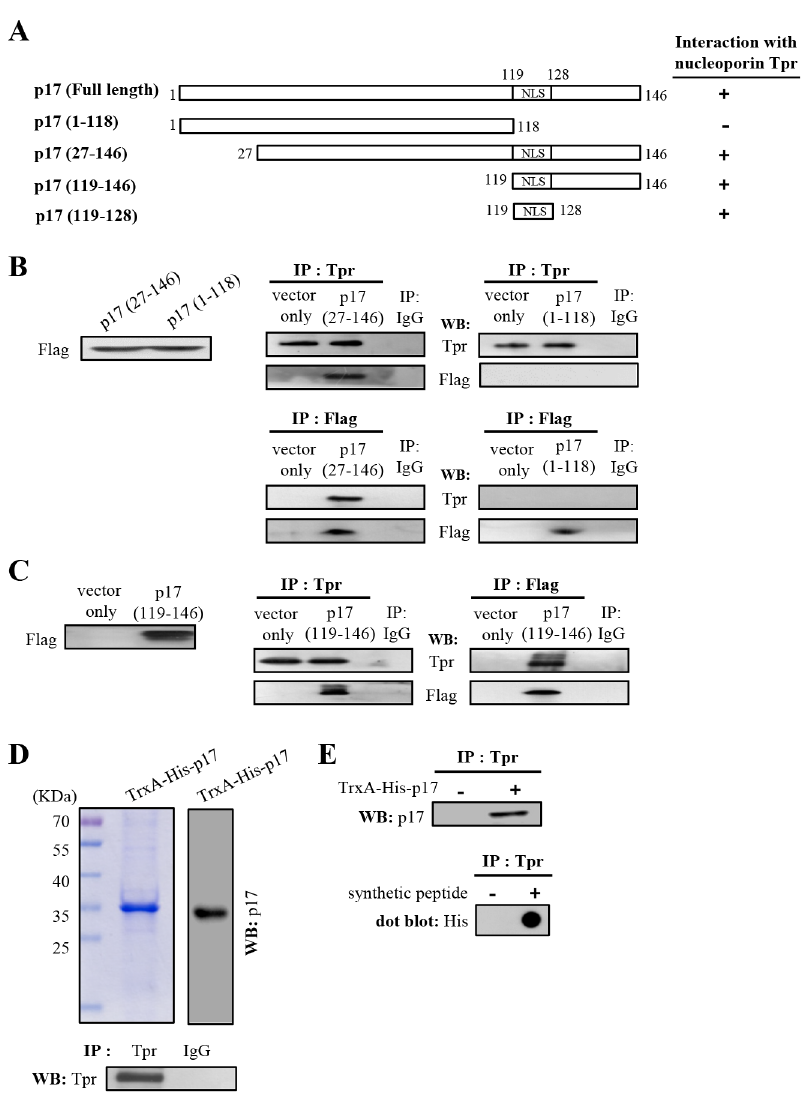
Fig 2. The NLS within p17 directly interacts with Tpr. (A) To map the region within p17 that was involved in Tpr binding, a series of truncated versions of Flag-tagged p17 constructs were established. Schematic representation of p17 deletion mutants is shown. The ability of the p17 and truncated p17 mutants to interact with Tpr is shown on theright hand side of the panel. +, strong binding;-, no binding. (B-C) Cellular lysates from Vero cells transfectedwith Flag-tagged p17 deletion vectors were immunoprecipitated with anti-Tpr and anti- Flag antibodies, respectively. Following immunoblotting analysis, Tpr and Flag-tagged p17 deletion proteins (1 – 118 and 27 – 146) (panel B) and p17 (119 – 146) (panel C) were detected by using Tpr and Flag antibodies. (D) Immunoprecipitation of Tpr by using an anti-Tpr antibody was performed. The immunoprecipitated Tpr proteins were separated by SDS-PAGE followed by Western blot assay using an anti-Tpr antibody (lower panel). Purified TrxA-His-p17 fusion protein was analyzedby SDS-PAGE followed by Western blot assay using an anti-p17 antibody (upper panel). Rabbit IgG was usedas a negative control. (E) I nvitro binding assays using a synthetic peptide (His-p17-NLS, His 6 -IAAKRGRQLD) and purified TrxA-His-p17 fusion protein were performed. The synthetic peptide His-p17-NLS (lower panel) and purified TrxA-His-p17 fusion protein (upper panel) were then subjected to analysis for their binding abilities to Tpr, as revealed by Western blot and dot blot assays, as indicated. The representative data are fromthree independent